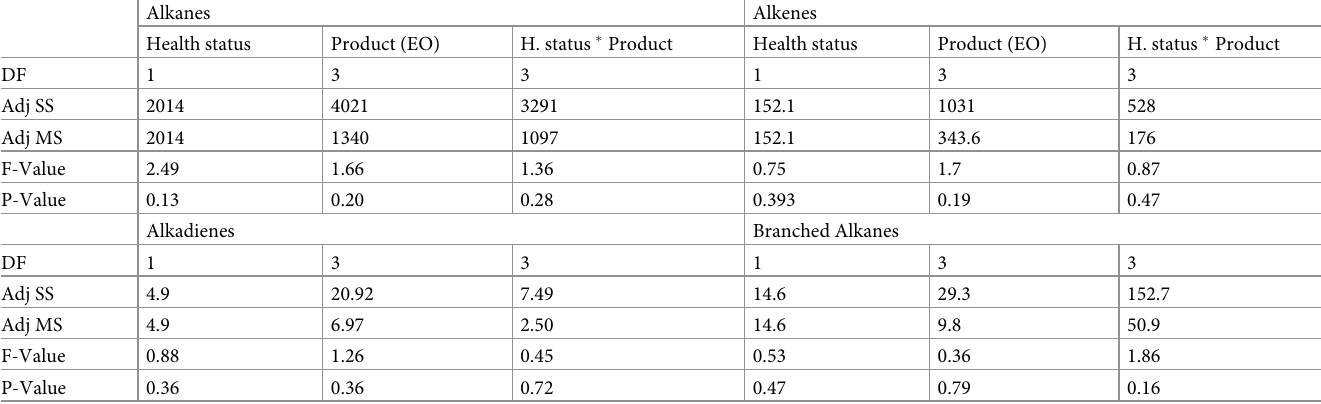
Table 4. Results on the analysis of variance (GLM) for groups of CHC from honeybees with different health status (healthy and Nosema -infected honeybees in Experiment II) fed on two EOEb harvested at different times (product) at 3000 ppm. Alkanes Alkenes